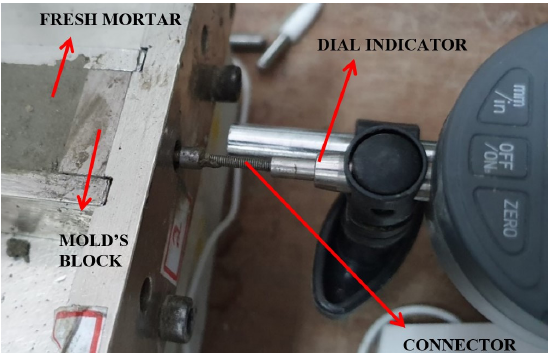
Figure 8. Final connection between the created elements and the dial indicator